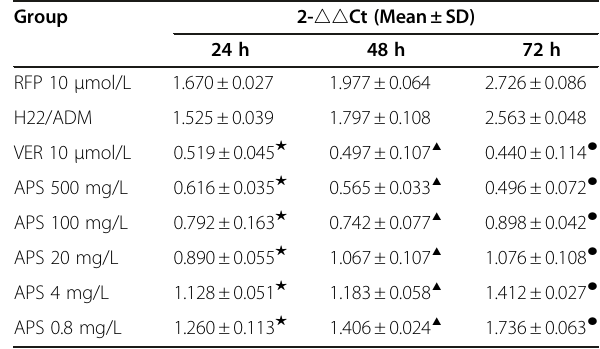
accumulation in H22/ADM cells (n=